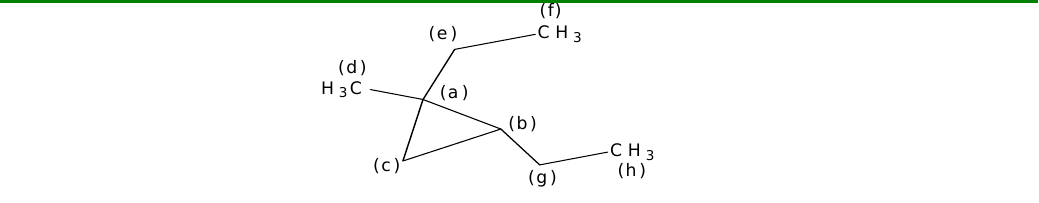
Table 18. Molecule of 1-methyl-1,2-diethylcyclopropane with the Following Atom Numbering and Their Total and Local (Atom) Quadratic